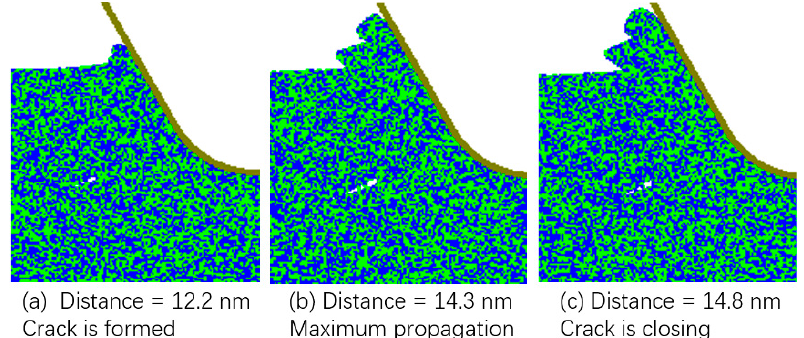
Figure 4. Crack formation and closing under t uc of 30 nm.